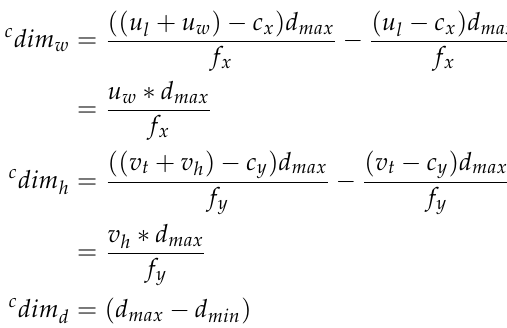
Figure 10. Experimental results of dynamic obstacle tracking with OpenLORIS-Scene market data sequence [29]. ( a ) An RGB image snapshot with all detected obstacles. ( b ) Corresponding Rviz [35]